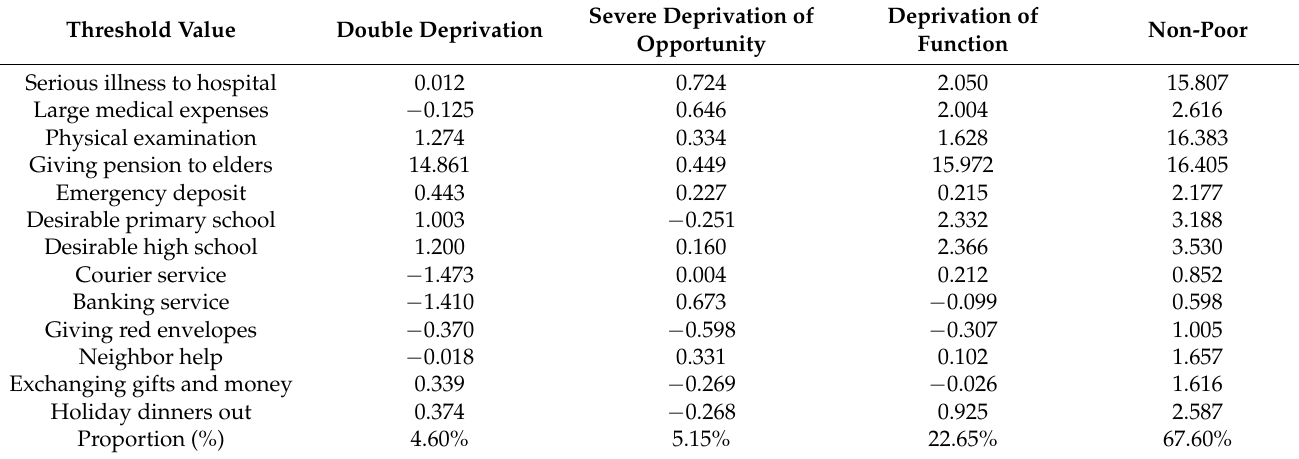
Table 4. Intercept estimation results of multiple deprivation